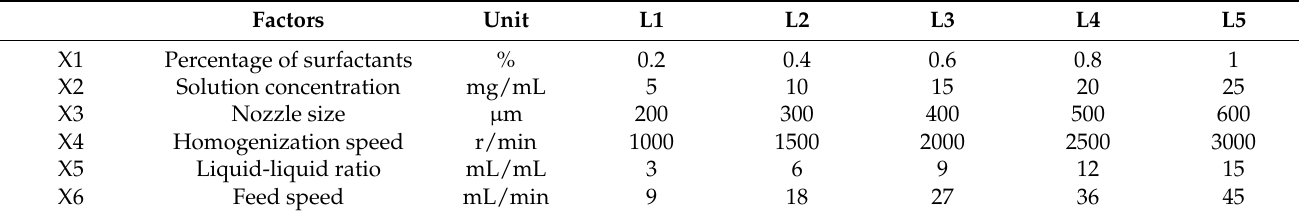
Table 1. Influencing factors and the corresponding levels